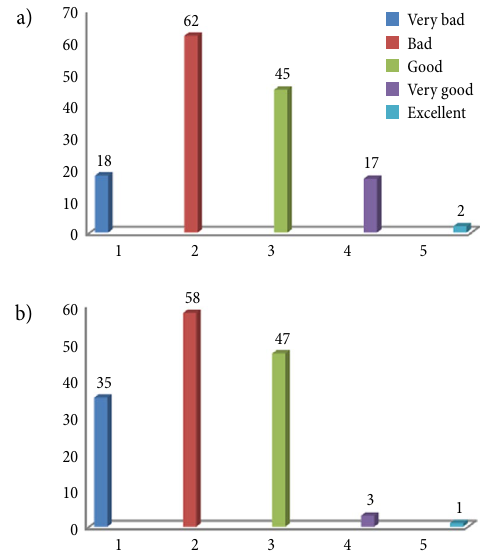
Fig. 3. User satisfaction with: a – audio information; b – tactile